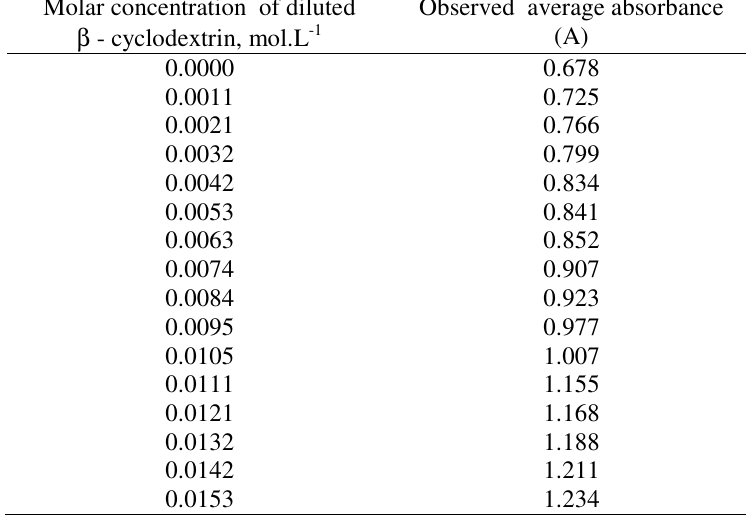
Table 2. Absorbance of the inclusion complex formed by addition of various concentrations of b - cyclodextrin to the imipramine hydrochloride solution with pH 7.4